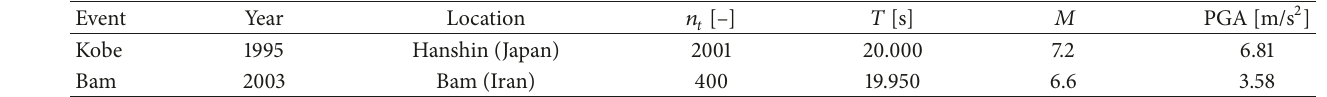
Table 2: Earthquake excitation list.